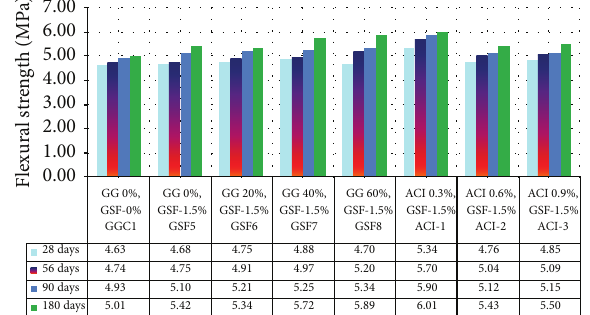
Figure 7: Compressive strength of concrete cured in NaCl (3%) solution for various mixes (40% stressed).